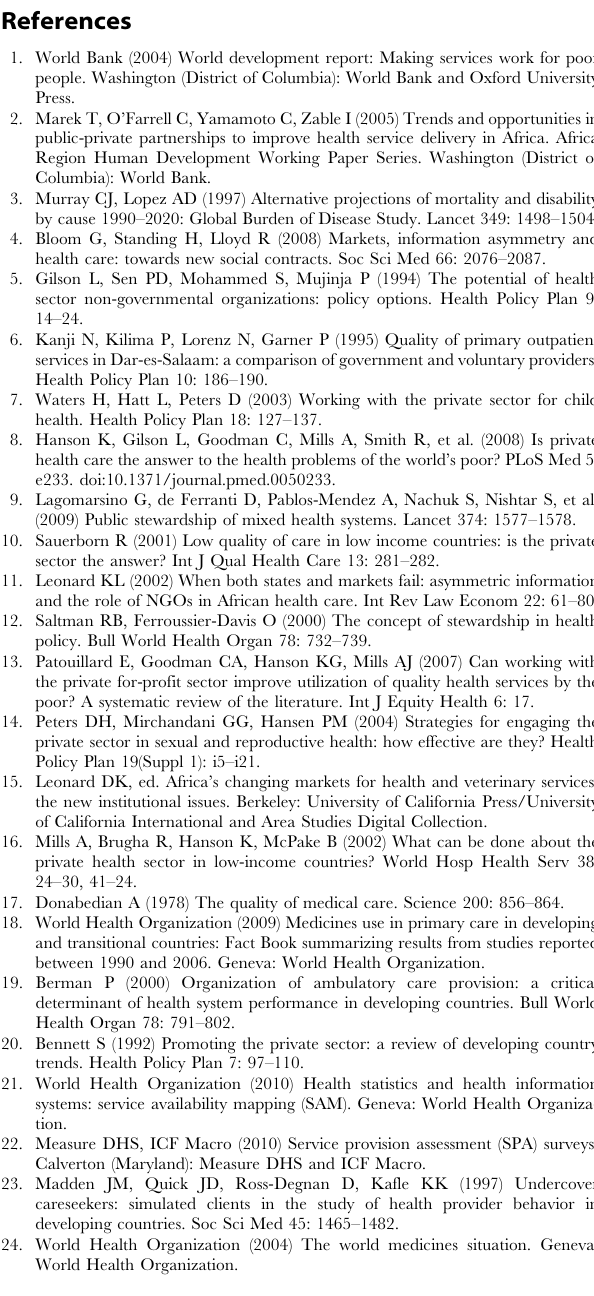
Table S8 Comparison of selected prescribing behaviours for patient visits to public-sector and formal for-profit private-sector care providers in LMICs.